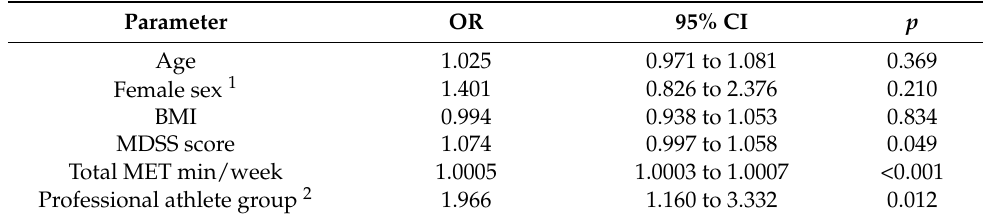
Table 3. Multivariable logistic regression analysis of independent predictors of high tendencies to ON behavior (ORTO-15 <